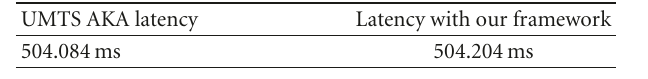
Table 1: Latency influence of the framework: UMTS AKA as an